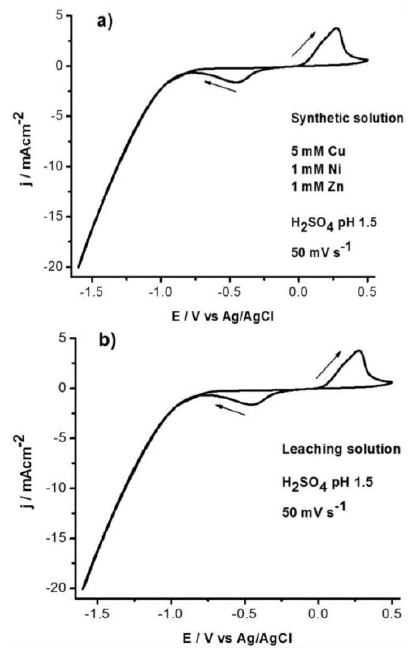
Figure 3. Cyclic voltammetries in: ( a ) H 2 SO 4 , pH 1.5 synthetic solution; and ( b ) H 2 SO 4 , pH 1.5 leaching solution. Scan rate of 50 mV·s −1 .